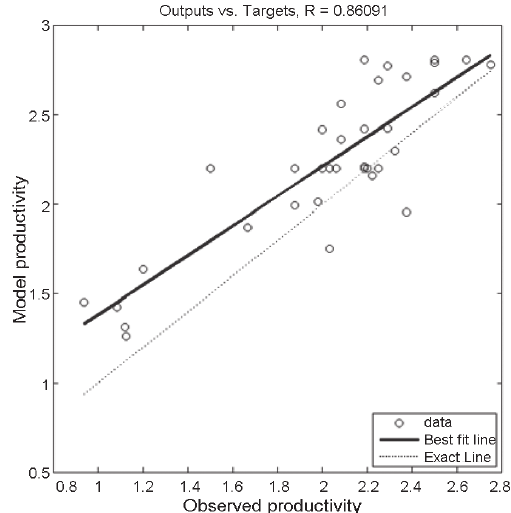
Fig. 4. A scatter plot of FF1